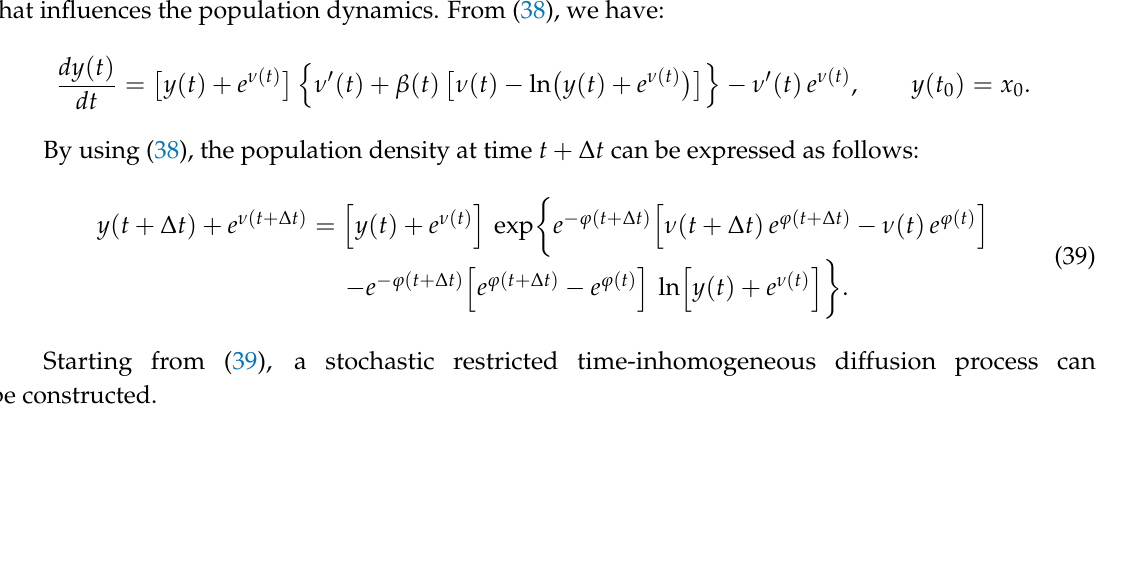
(cid:0) (cid:1) 2 1 − e − 1.2 t